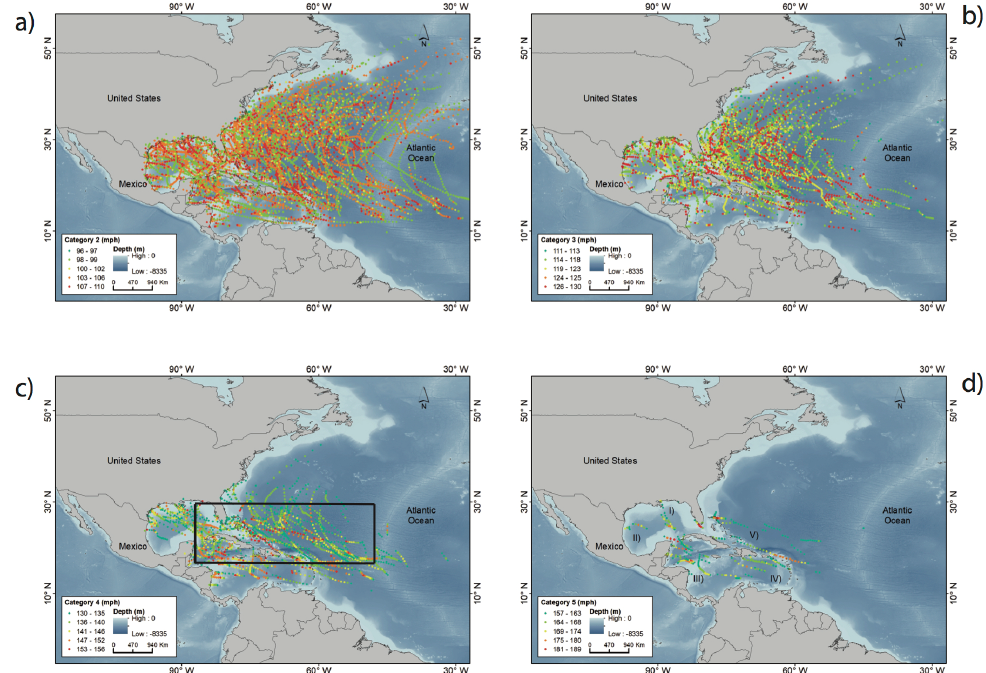
Figure 9. Speed distribution map of Atlantic hurricanes for each of the categories: ( a ) Category 2; ( b ) Category 3; ( c ) Category 4 where the main zone (marked by the rectangular box) of cyclogenesis seems to fall outside the Gulf of Mexico. In addition, in panel ( d ) we show the region of cyclogenesis for Category 5 Atlantic hurricanes that highlights five areas of concentration around (I) the east coast of the United States, (II) the Northeast of Mexico, (III) the Caribbean Sea, (IV) the Central American coast, and (V) the north of the Greater